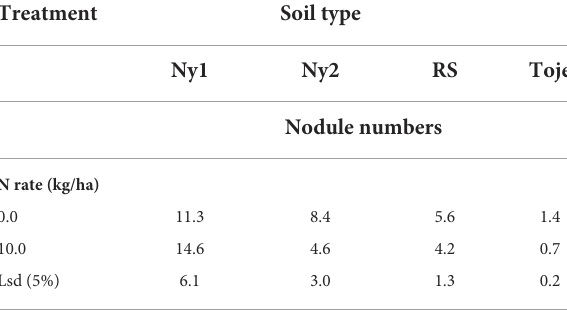
TABLE 5 Effect of varying rates of N on nodule numbers on soils * .